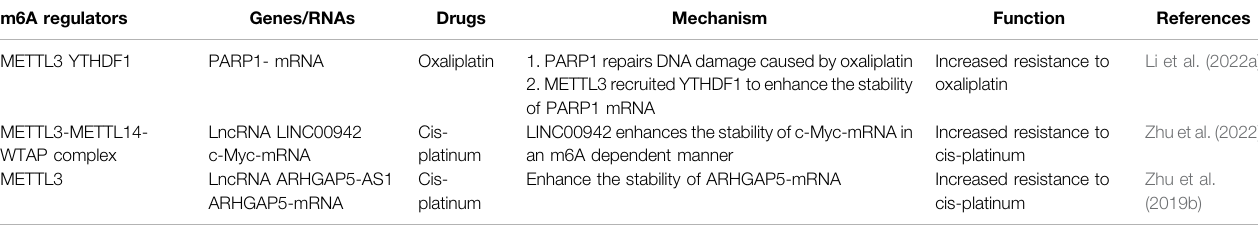
TABLE 4 | The roles of different m6A regulators in gastric